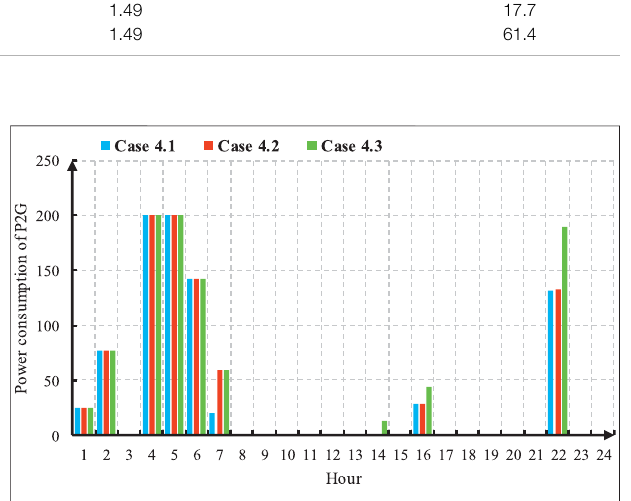
FIGURE 6 | Power consumption of P2G in different